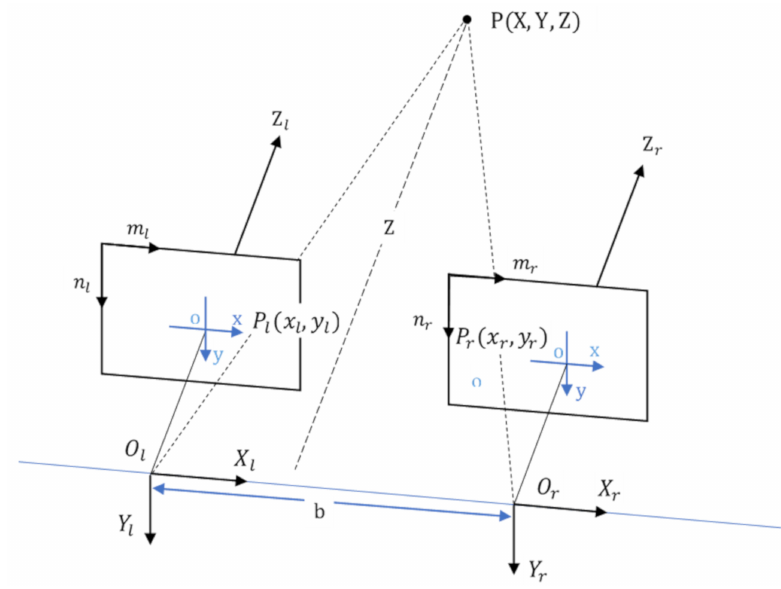
Figure 2. The binocular stereo vision localization